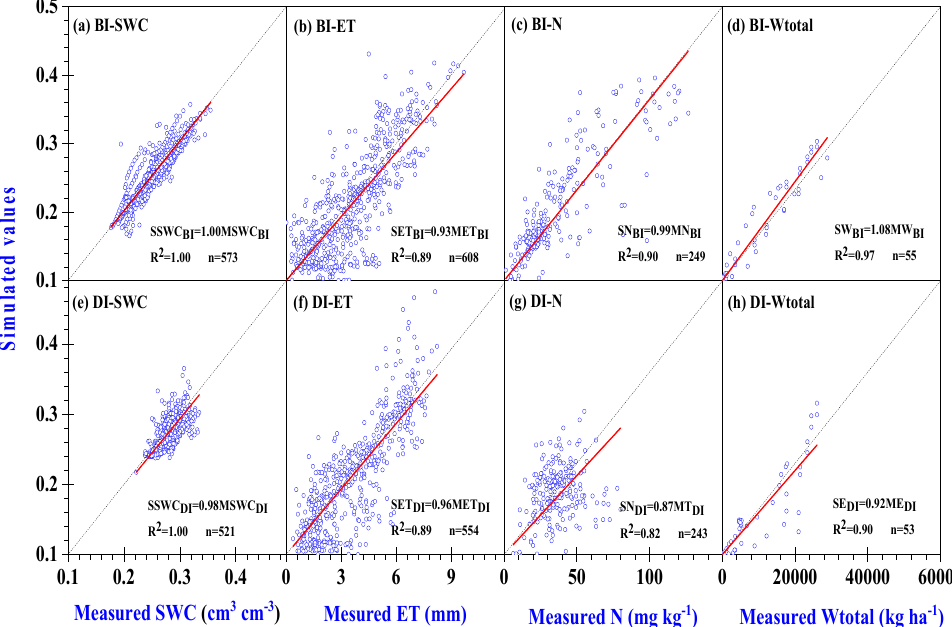
Figure 5. The relationship between measured and simulated soil water content (SWC), evapotranspiration (ET), soil NO - -N content (N), and total dry matter (Wtotal) under film-mulching 3